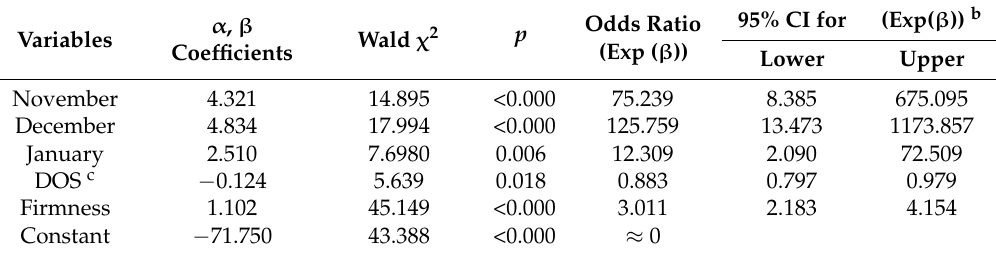
Table 3. Parameter estimates for the multiple logistic regression